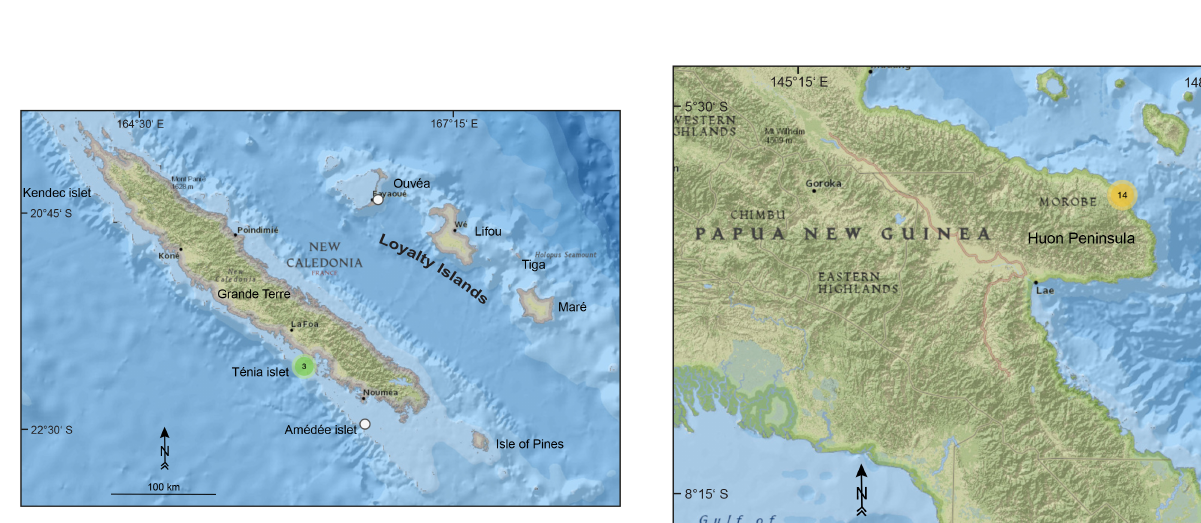
Figure 10. Map showing islands in New Caledonia considered in this article (green and white circles). Basemap: “National Ge- ographic Map”, with data from National Geographic, Esri, Garmin, HERE, UNEP-WCMC, USGS, NASA, ESA, METI, NRCAN, GEBCO, NOAA and INCREMENT P Corp.